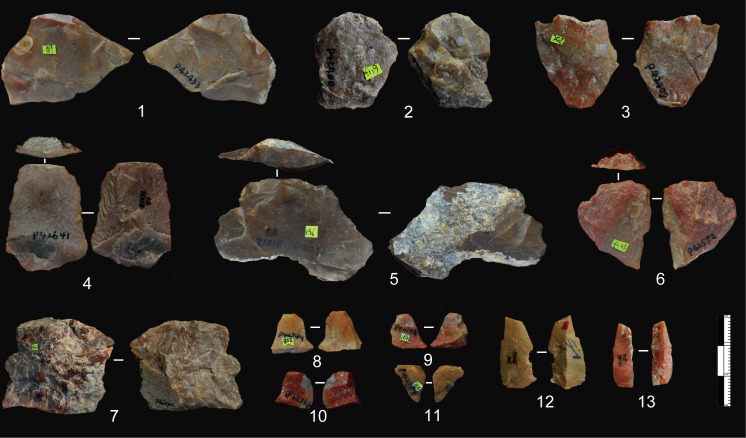
Freehand flakes from DGT.The freehand flakes show Hertzian initiation, i.e. waves, bulbs of force, distinct striking platforms.